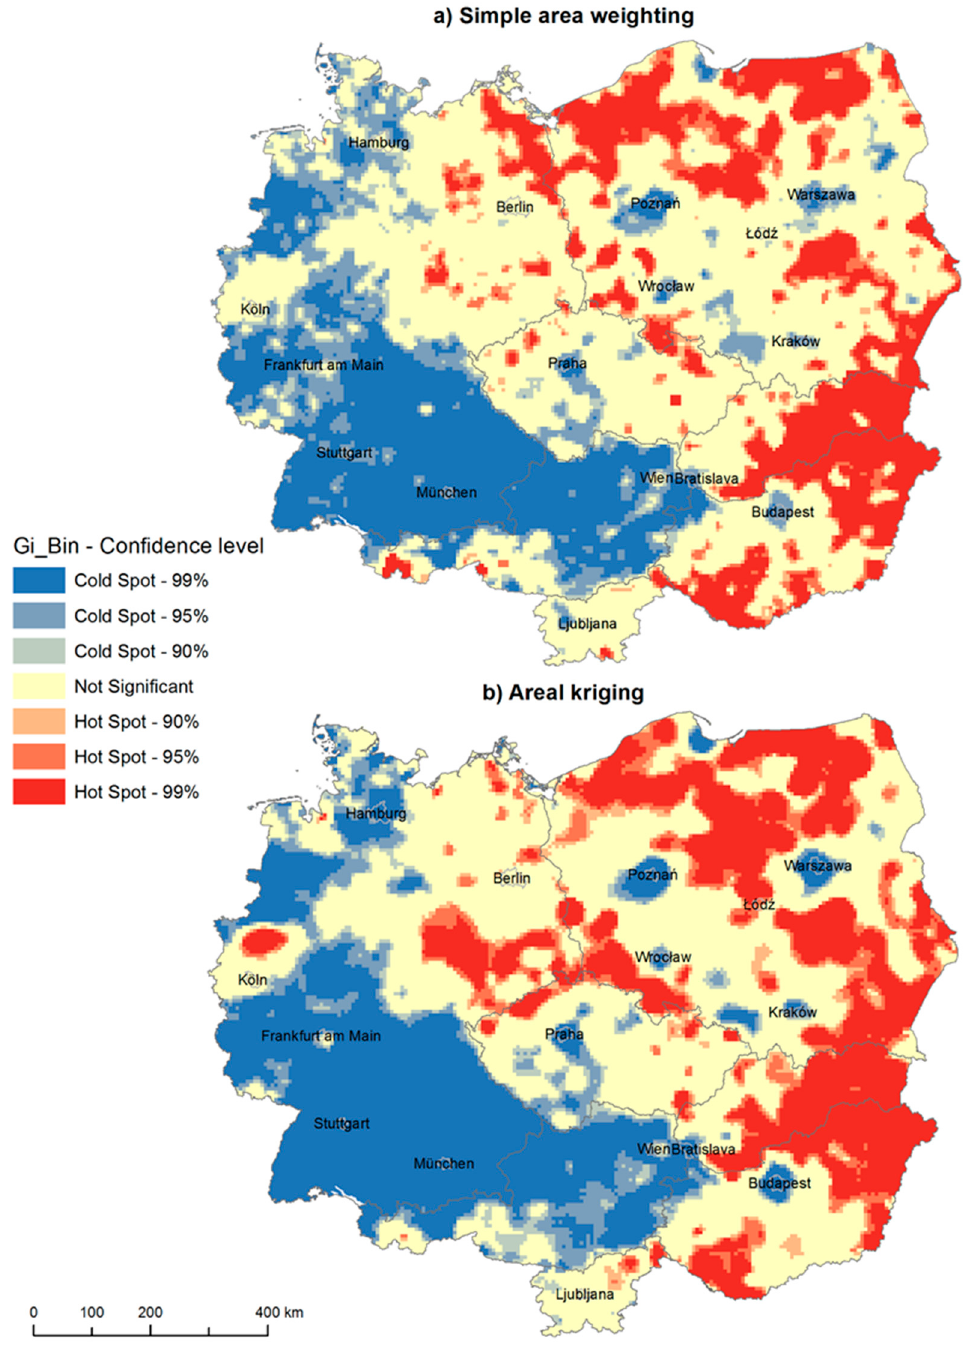
Figure 5. Hot spot analysis of unemployment in a 6 km grid, simple area weighting ( a ) and areal kriging ( b ). Source: © EuroGeographics for the administrative boundaries, European Commission, Eurostat/GISCO